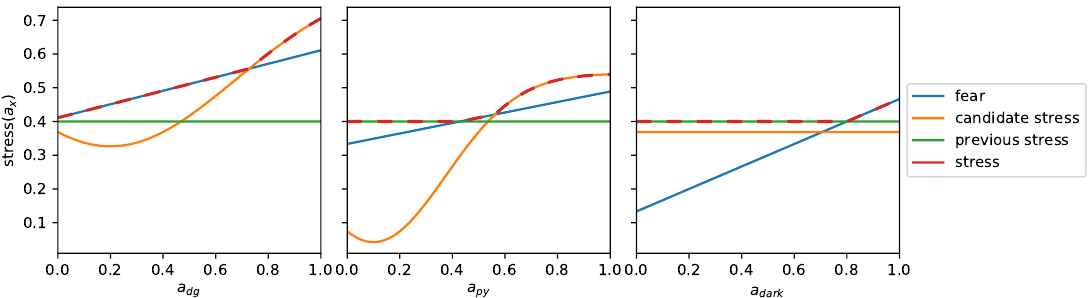
Figure 8. Plots showing the calculation of stress as it depends on other functions. Each plot